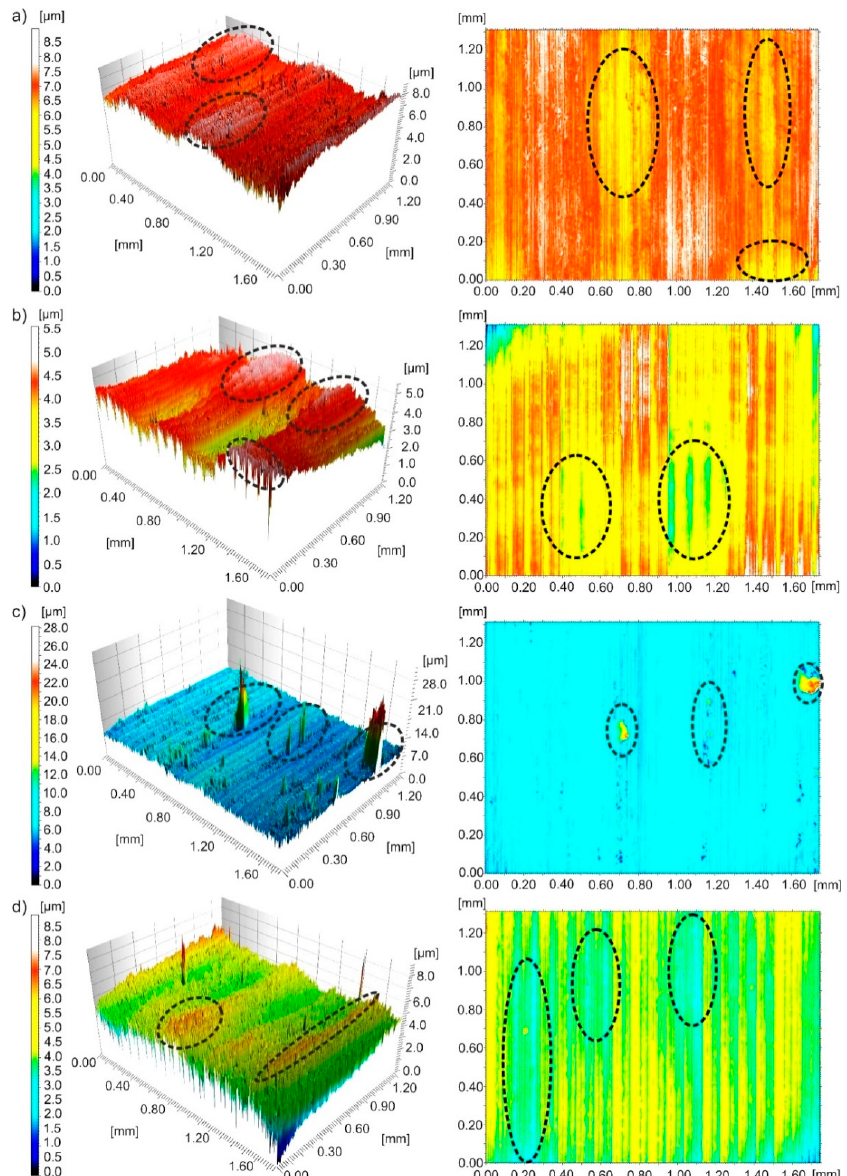
Figure 10. Three-dimensional images and contour maps of the surface machined with a speed of v c ~280 m/min and feed of f ~0.094 mm/rev obtained under processing conditions: ( a ) dry; ( b ) wet; ( c ) v c ~280 m / min and feed of f ~0.094 mm / rev obtained under processing conditions: ( a ) dry; ( b ) wet; MQL; ( d ) MQL+EP. ( c ) MQL; ( d ) MQL +